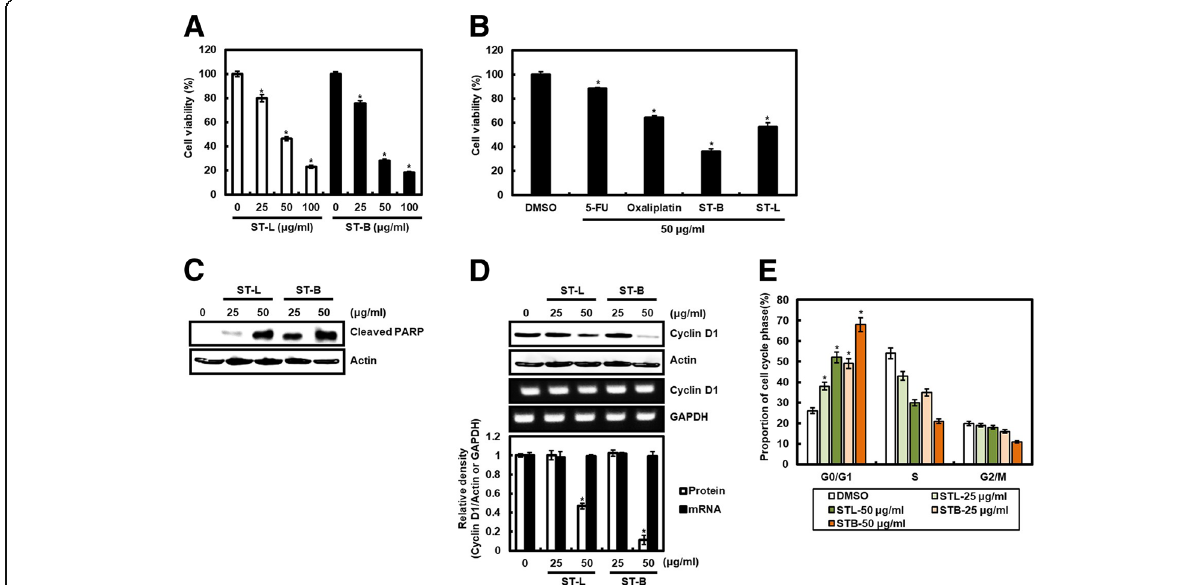
Fig. 1 Effect of STL and STB on the cell viability, and the level of cleaved PARP and cyclin D1. a and b Cell viability of SW480 cells analyzed by MTT assay. * P < 0.05 compared to the cells without ( c ) The cleaved PARP level analyzed by Western blot analysis in SW480 cells treated with STL and STB for 24 h. Actin was used as loading control. d The protein and mRNA level of cyclin D1 analyzed by Western blot analysis and RT-PCR in SW480 cells treated with STL and STB for 24 h. Actin or GAPDH was used as loading control. The density of protein and mRNA bands was calculated using the software UN-SCAN-IT gel version 5.1 (Silk Scientific Inc. Orem, UT, USA). * P < 0.05 compared to the cells without STL and STB. e Proportions of the cycle phase analyzed by flow cytometry in in SW480 cells treated with STL and STB for 24 h. * P < 0.05 compared to the cells without STL and STB.